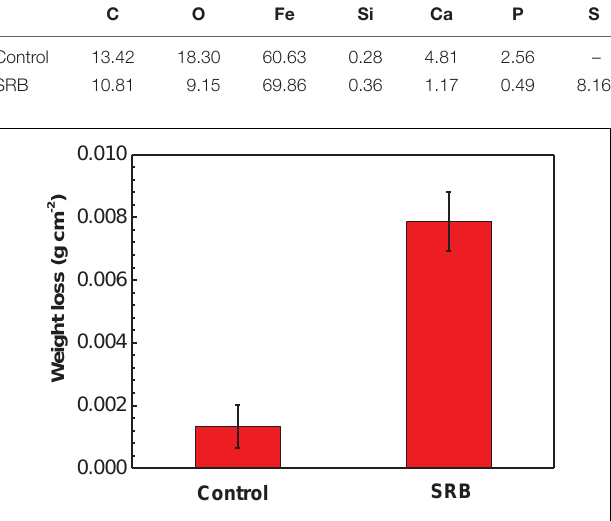
FIGURE 4 | Weight loss results of specimens covered with deposit in the absence and presence of SRB after 14-days of incubation in CO 2 -saturated simulated formation water. (Error bars represent standard